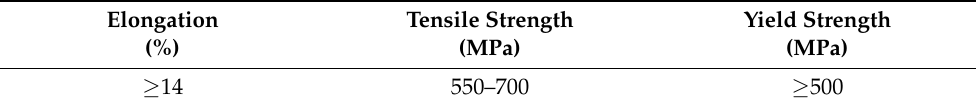
Table 2. Mechanical properties of S500MC.